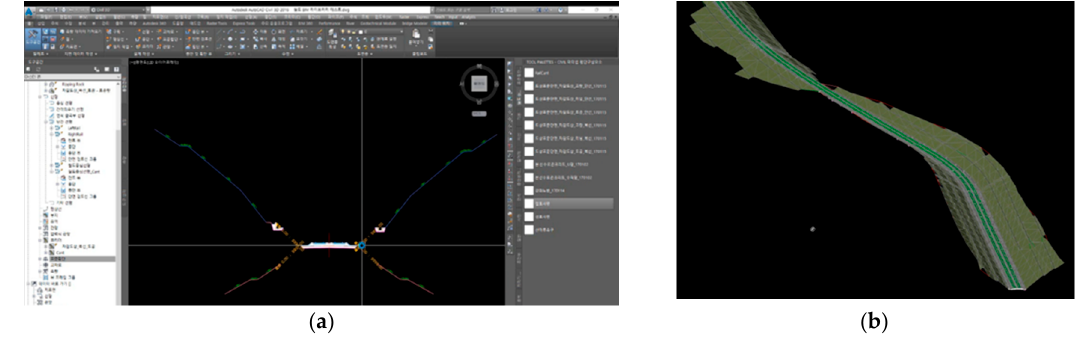
Figure 1. ( a ) Standard crossing creation and ( b ) corridor model creation. Appl. Sci. 2020 , 10 , x FOR PEER REVIEW